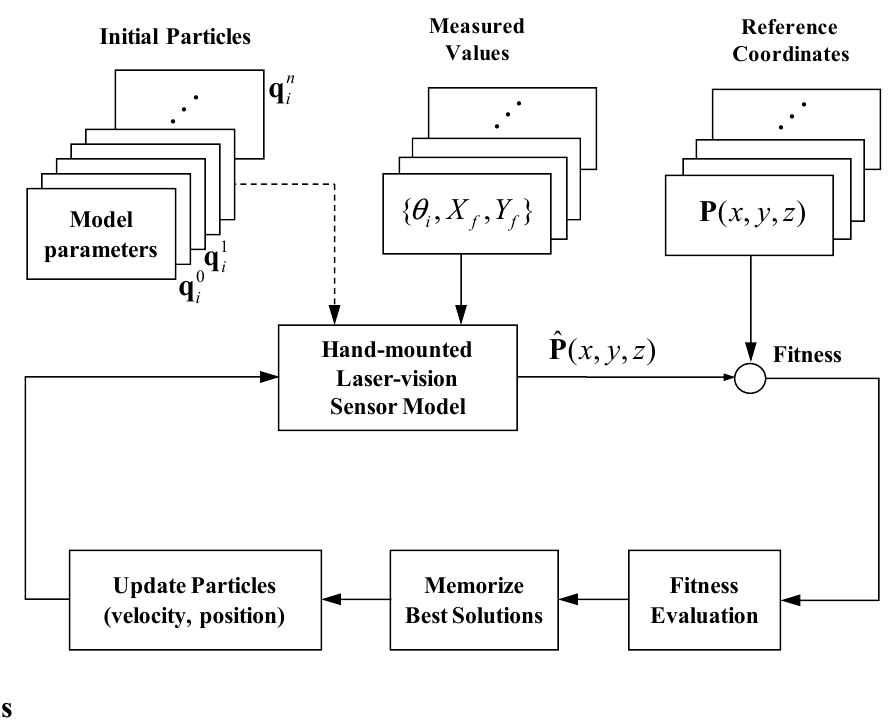
Figure 7. Schematic diagram of the PSO-based parameter